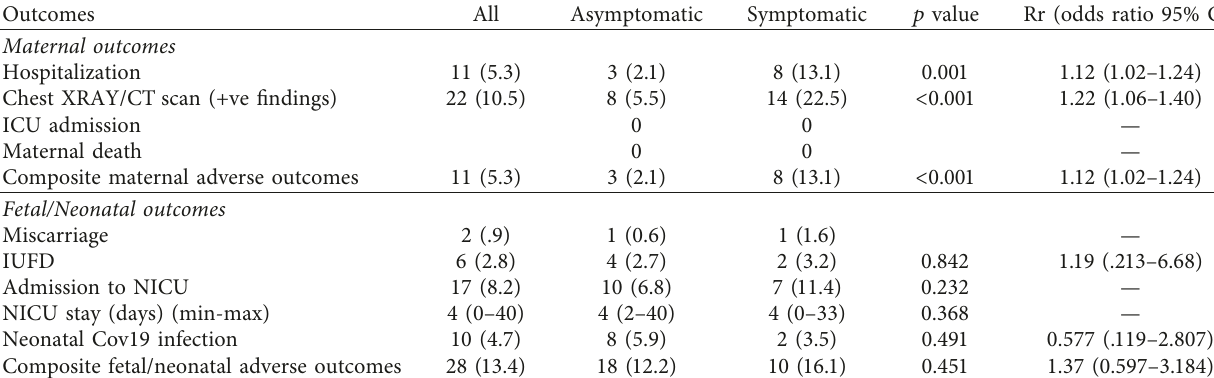
Table 3: Adverse perinatal